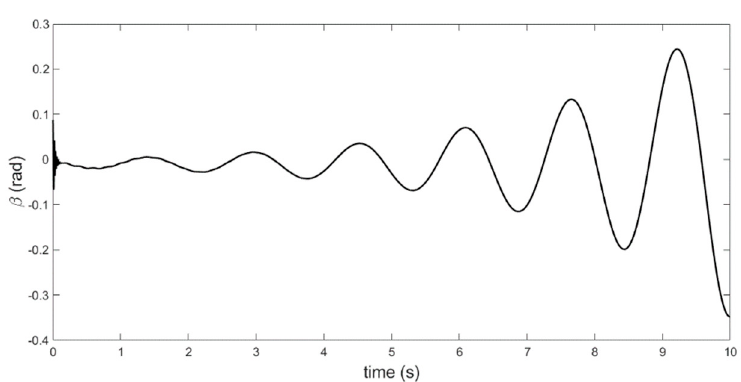
Figure 12. Time response of beta in upper speed of flutter (35 m/s).